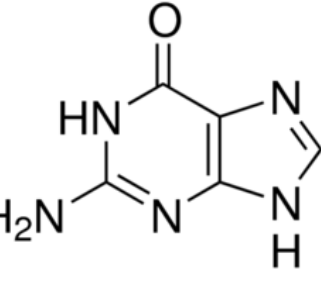
Table 1. Crystal data along with structure refinement values for compounds 1 and 2